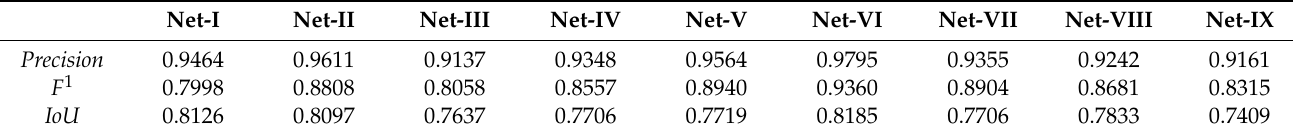
Table 14. Evaluations of validation set with class metrics of cable